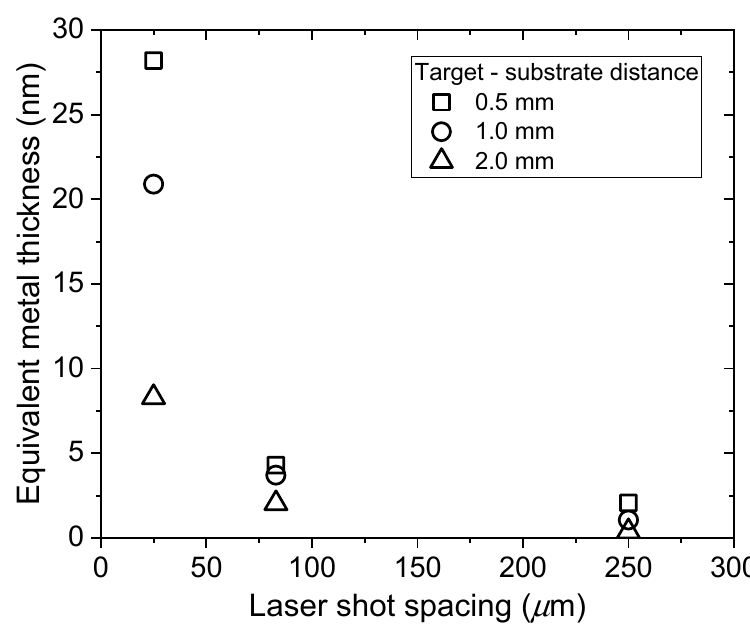
Figure 9. Equivalent thickness of Au NP films deposited at atmospheric pressure using different values of target-substrate separation and laser shot spacing.